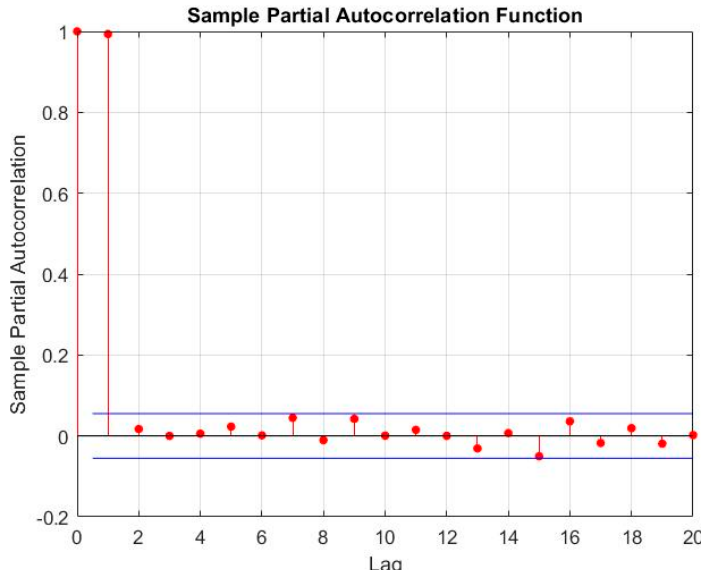
Figure 24. EUR–USD: PACF analysis.